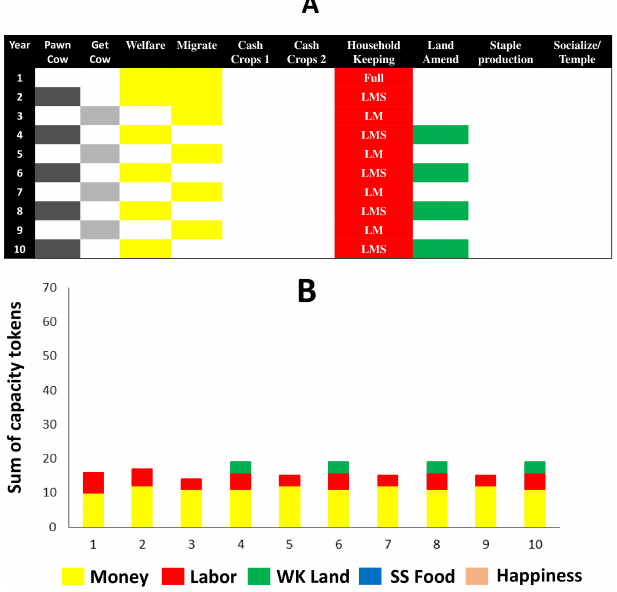
Fig. 11. (A) Simulation of a single-family strategy resulting in an outcome in the lower limit of the solution space in The Flow of Peasant Lives. Dice outcomes are assumed to favor the household team in every round. The household team pawns its cow (savings), uses an intermediate level of labor, and combines welfare and other government payments with sporadic migratory labor. L = labor; M = money; S = supplying food for family consumption. (B) Dynamics of rapid capacity reproduction resulting from the strategy shown in (A). Capacity levels oscillate noticeably while remaining low. The horizontal axis shows the sequence of